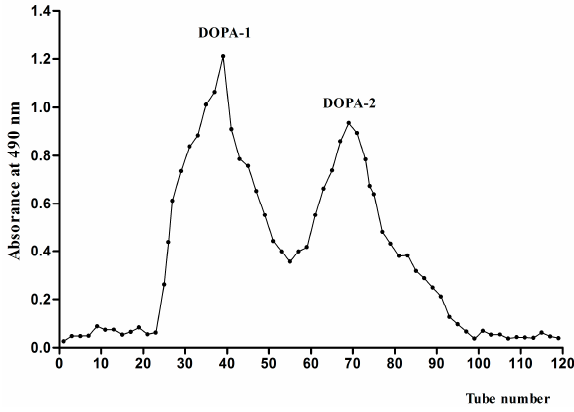
Figure 1. Elution profile of DOPA on a Sephacryl S-300 gel-permeation chromatography column.